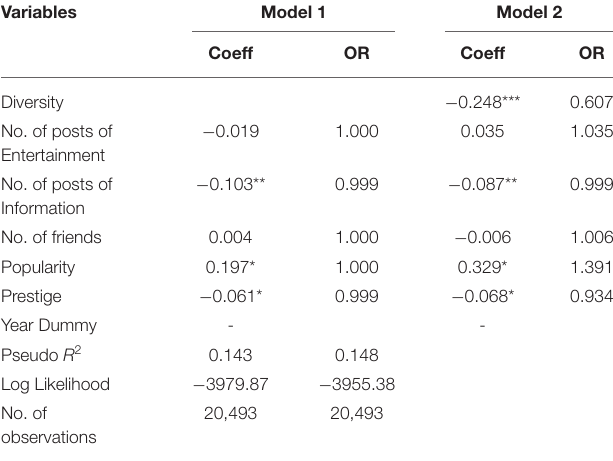
TABLE 4 | Regression